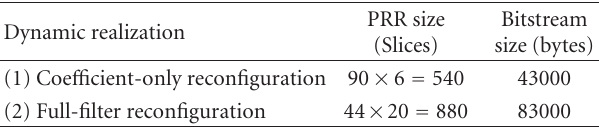
Table 4: PRR measures for both dynamic partial reconfiguration system